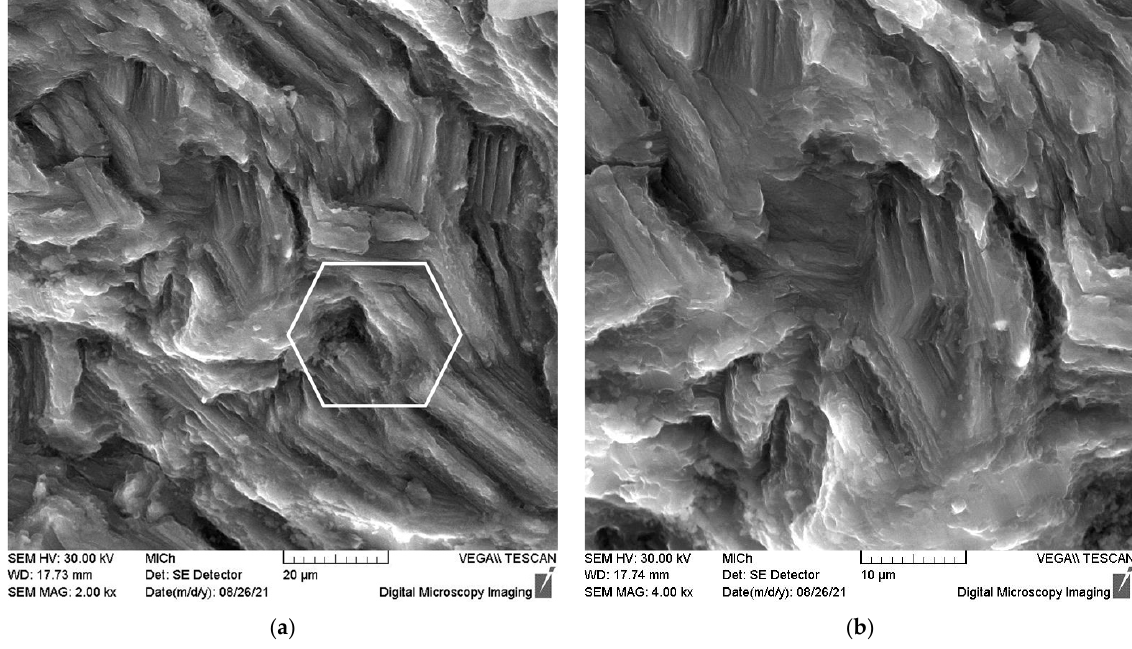
Figure 17. Fatigue fracture surface with uncovered basal planes ( a ) and fatigue striations ( b ).